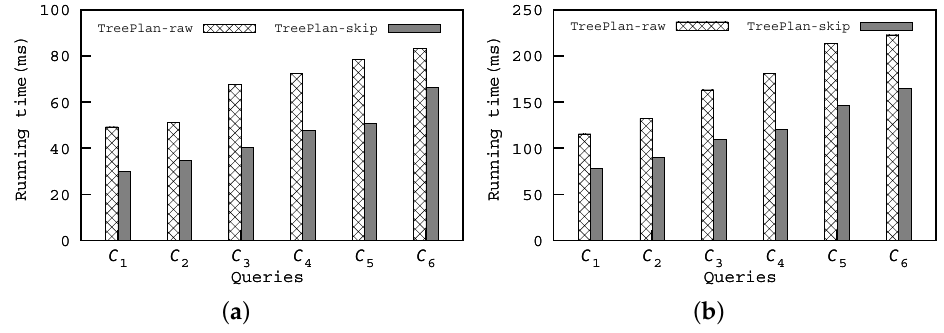
Figure 8. Effect of skipping invalid candidate elements. ( a ) Source Codes. ( b )